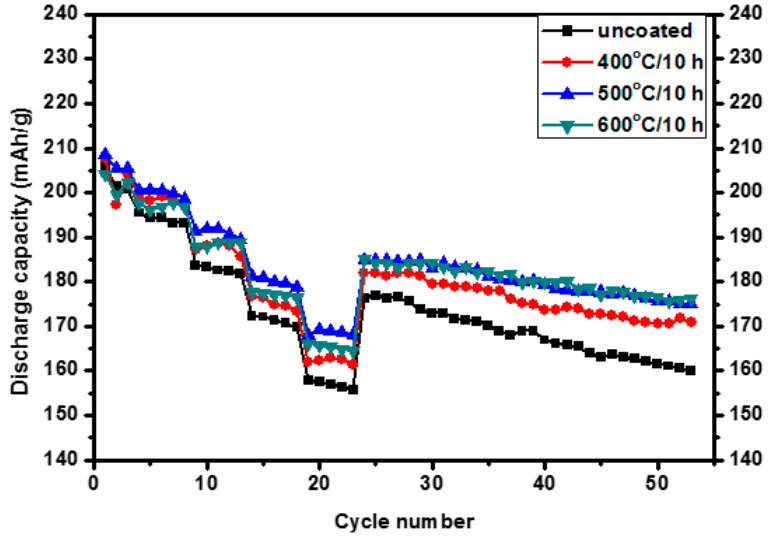
Figure 6. Electrochemical performance of the uncoated and 0.08 wt % Al 2 O 3 -coated Li(Ni 0.6 Co 0.2 Mn 0.2 )O 2 samples annealed at different temperatures for 10 h and cycled between 3.0 and 4.5 V at various C rates.